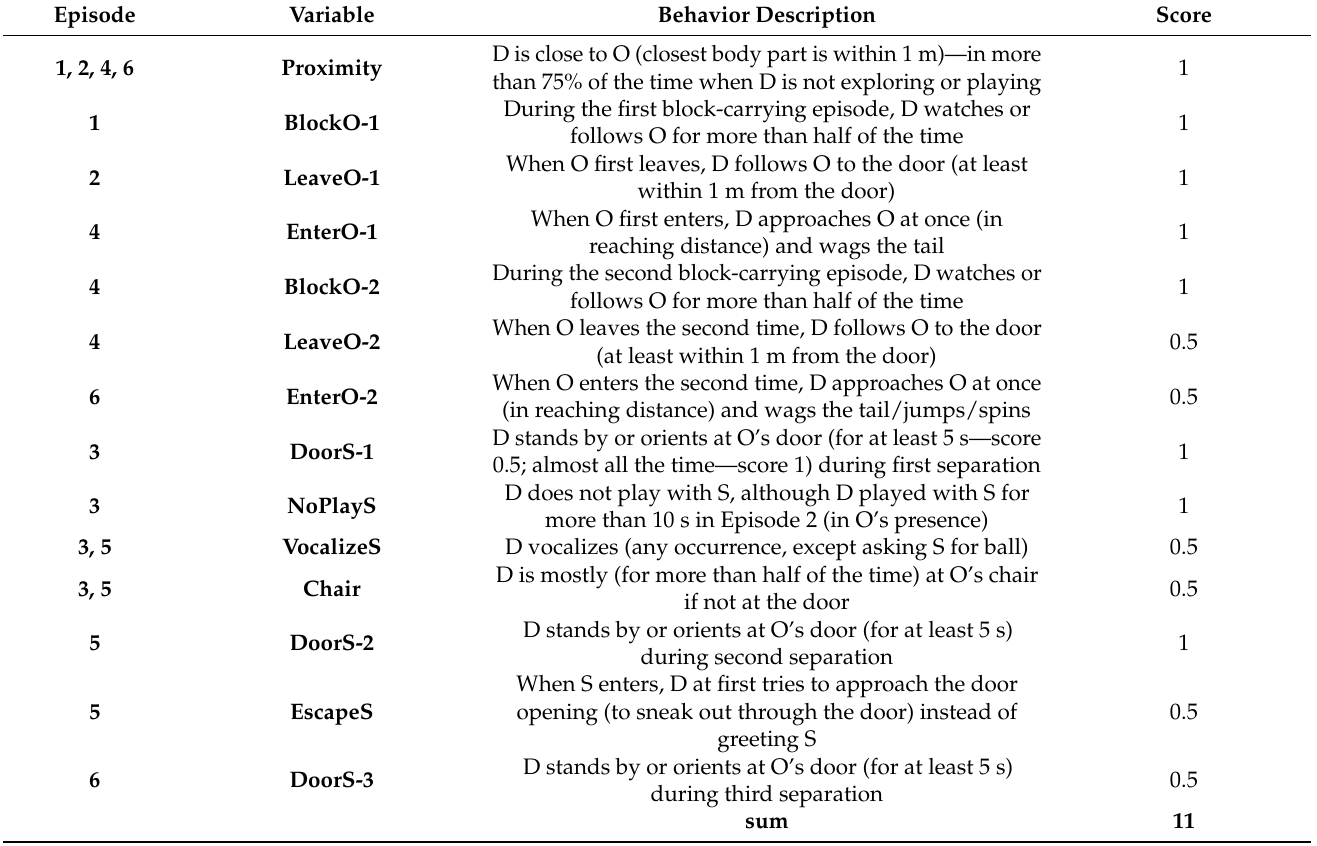
Table 1. Description of the Strange Situation Test behavioral variables related to dogs’ attachment towards the owner. D: dog; O: owner; m: meter; s: second; S: